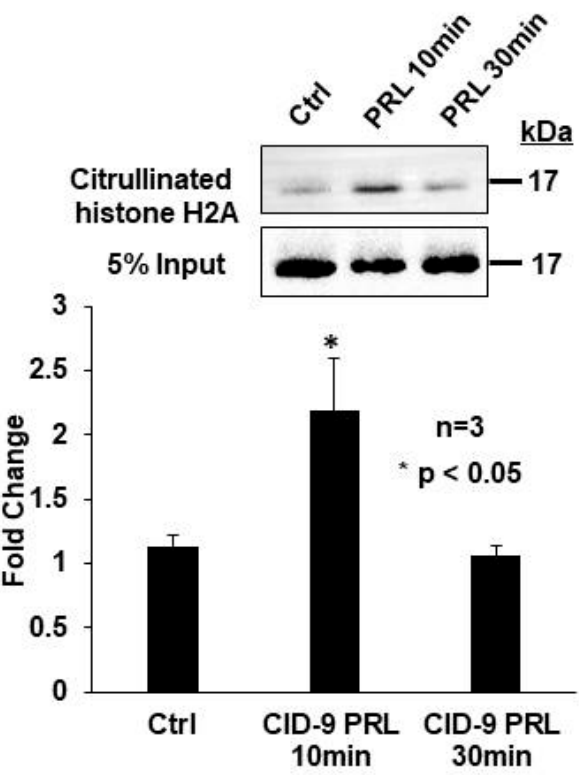
Figure 3. Prolactin induced histone H2A citrullination in mouse mammary epithelial CID-9 cells. CID-9 cells were treated with vehicle or 5 µ g / mL prolactin for 10 and 30 min. Equal amounts of lysate from each time point were labeled with biotin-PG and enriched with streptavidin-conjugated agarose beads. A 5% input sample was removed before enrichment and served as the loading control. Citrullinated histones and 5% input samples were examined by Western blot analysis, and membranes were probed with the anti-histone H2A antibody. The top panel shows a representative Western blot, while the bottom panel represents the quantification of multiple Western blots using BioRad Image Lab 4.0. Data are presented as means +/ − SEM and separated using ANOVA SNK ( n = 3, * p < 0.05).